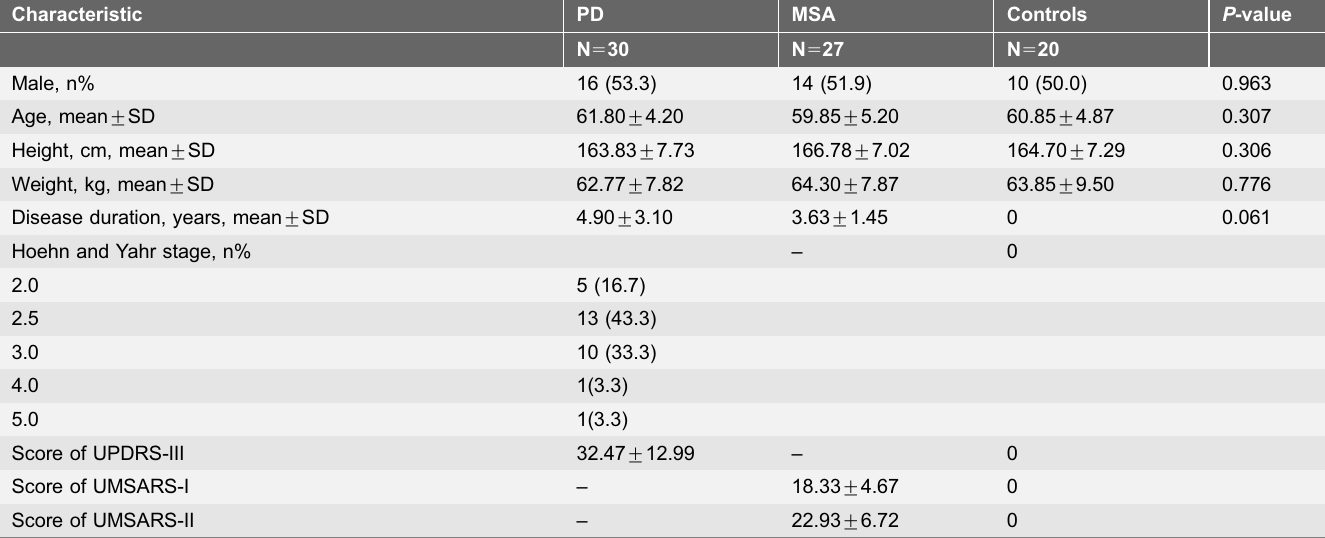
Table 1. Clinical and Demographic Features for PD, MSA and